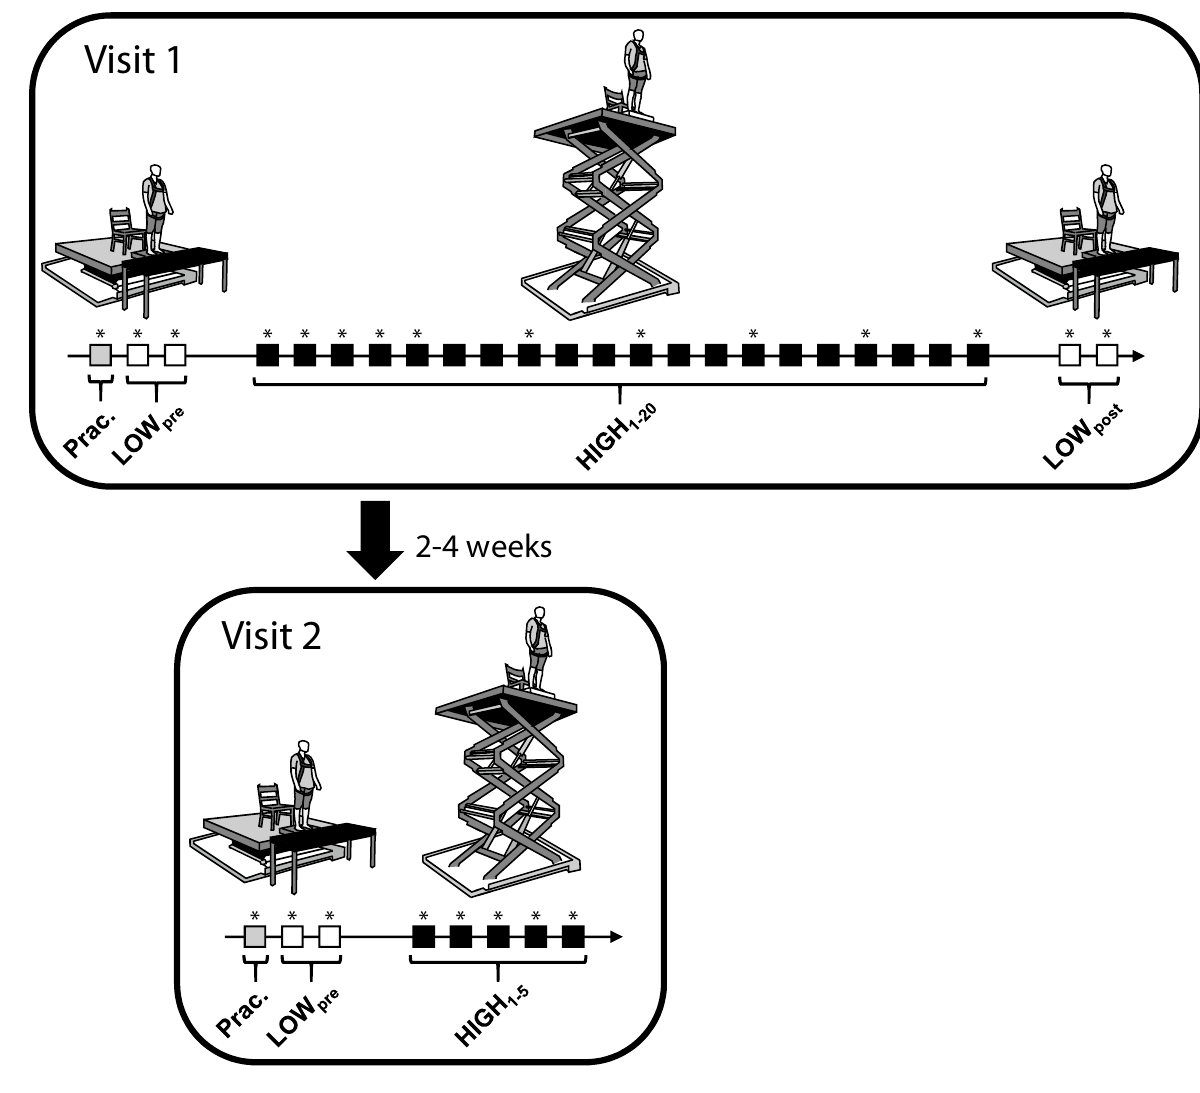
Figure 1. Flow chart outlining the experimental protocol. Participants completed a series of 90-s trials of quiet standing at LOW (0.8 m above ground, away from edge) and HIGH (3.2 m above ground, at edge) threat conditions on two visits to the lab separated by 2–4 weeks. Each square represents a single 90-s trial; open squares represent trials completed at the LOW condition, while filled black squares represent trials completed at the HIGH condition. During both visits, participants first completed a single 90-s practice trial (grey square) at the LOW condition. Trials in which questionnaires were administered to assess cognitive and emotional state are indicated with an